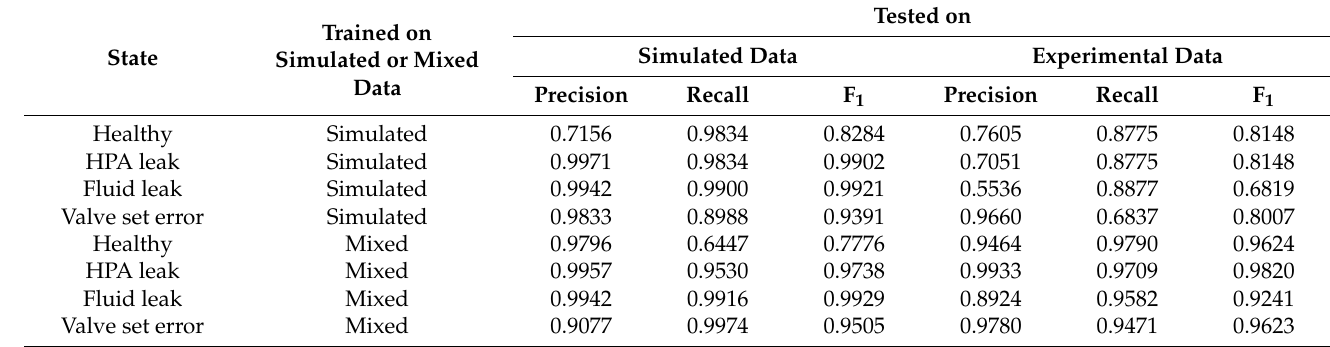
Table 2. The performance metrics for each state by the GCAEC model on a 1-s sampling window.